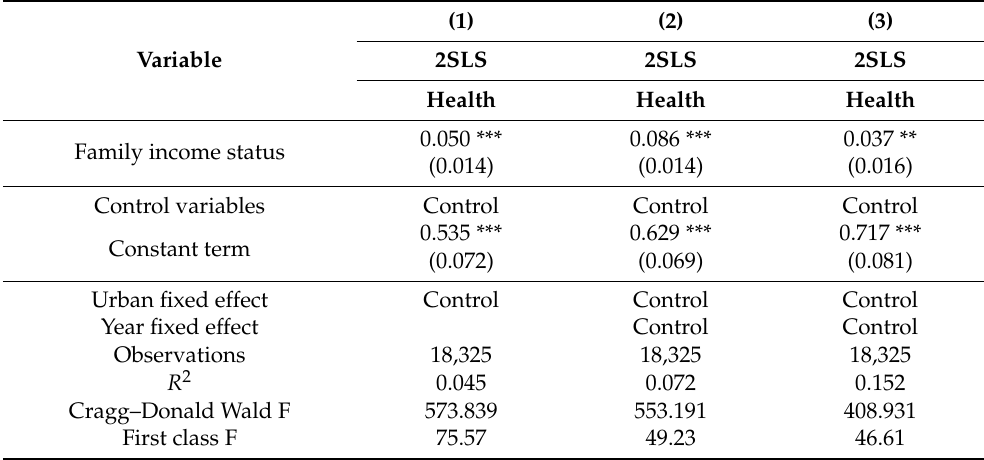
Table 8. Empirical estimation results of least square